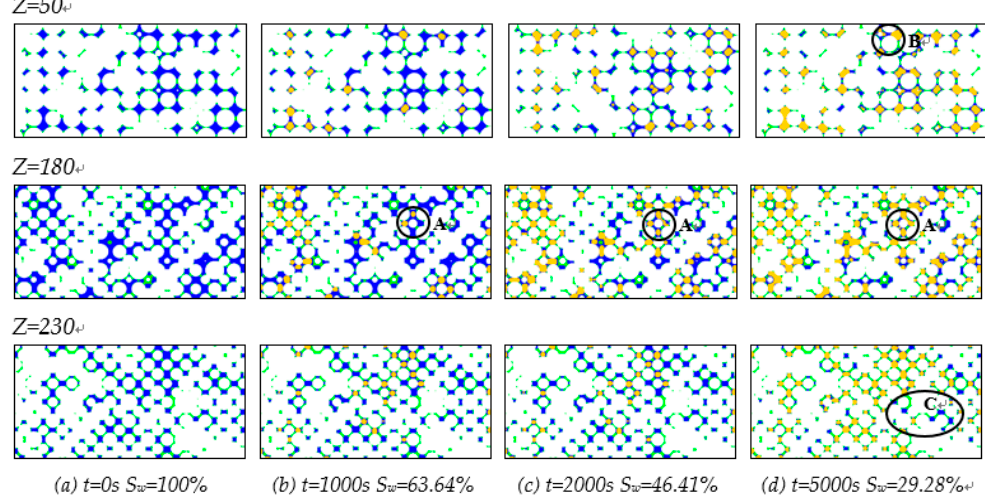
Figure 14. Distribution of gas and water on different cross sections of core 24 # under laboratory experimental temperature and pressure conditions.